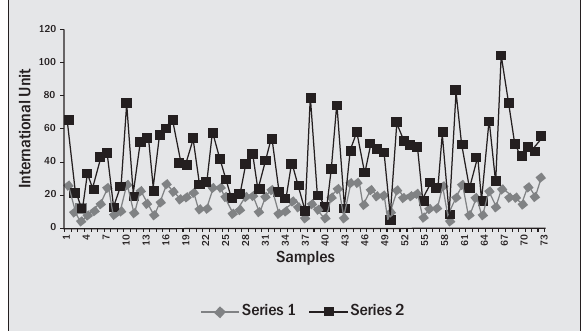
Figure – Reactivity of the serum samples in automated assays